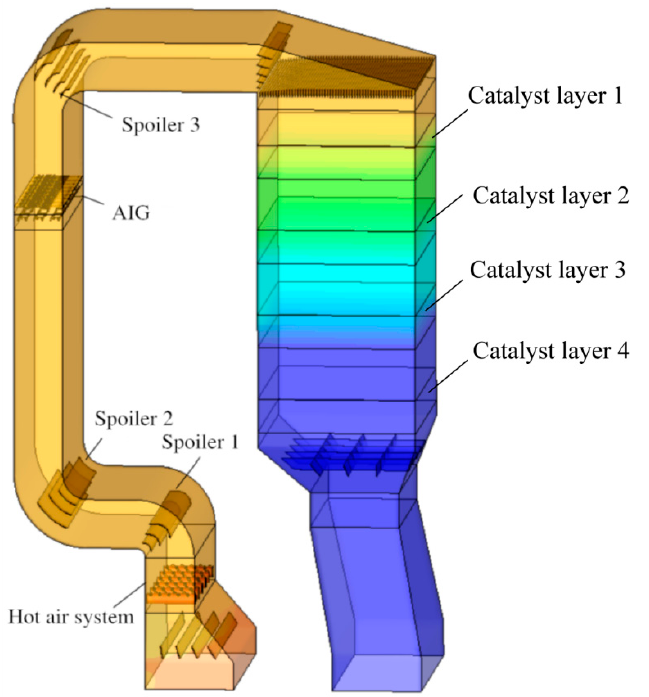
Figure 1. Three-dimensional simulation diagram of SCR reaction device (including guide vanes).